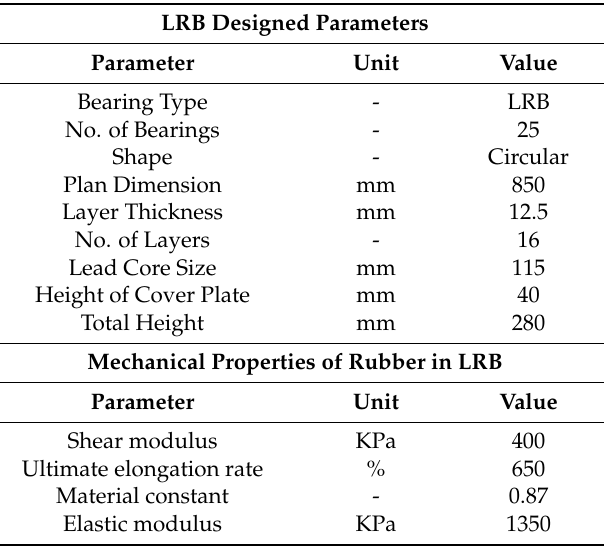
Table 2. Properties of LRB.